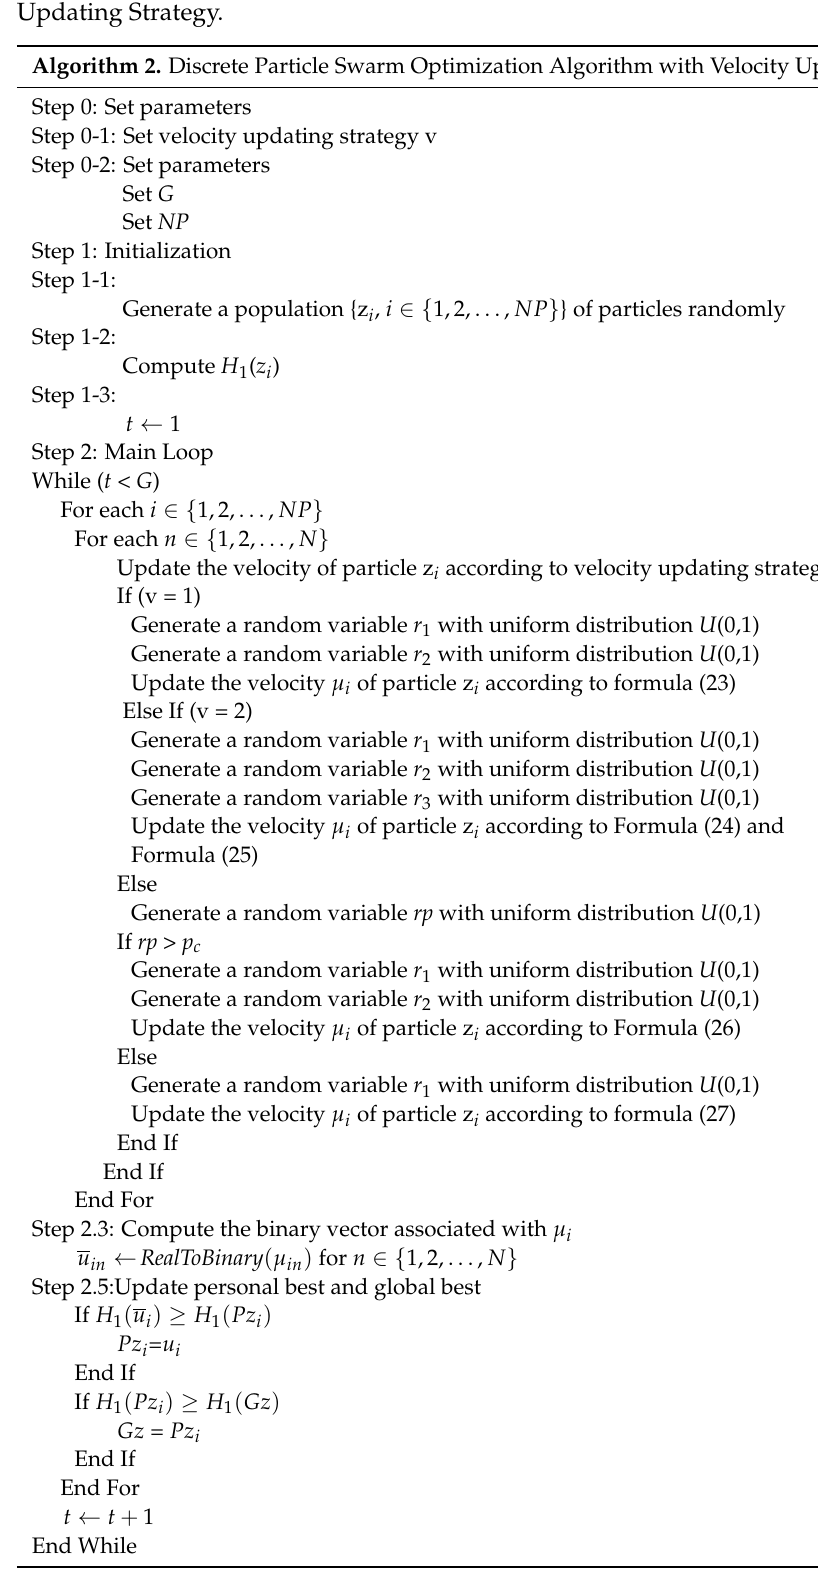
Algorithm 2. Discrete Particle Swarm Optimization Algorithm with Velocity Updating